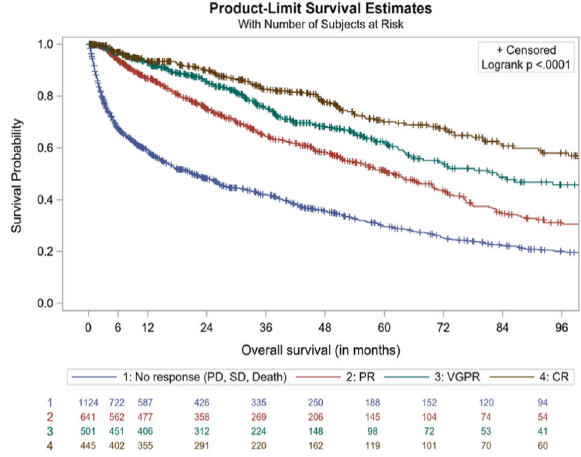
Fig. 2 Kaplan – Meier graph of OS by hematologic response at 3 months after fi rst-line treatment initiation, 2004 – 2018. CR complete response, PD progressive disease, PFS progression-free survival, PR partial response, SD stable disease, VGPR very good partial